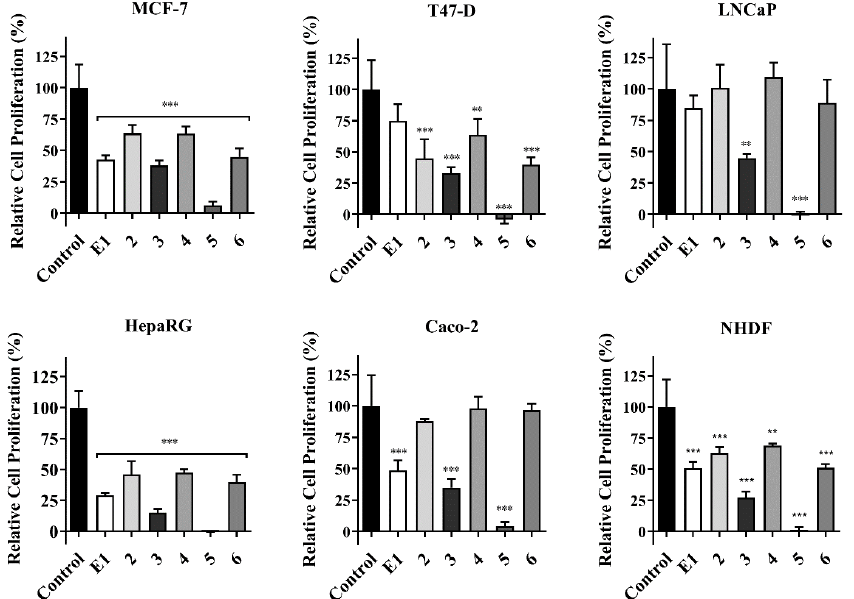
Figure 2. Relative cell proliferation of MCF-7, T47-D, LNCaP, HepaRG, and Caco-2 cancer cells and normal fibroblasts (NHDF) exposed to the tested compounds for 72 h at 30 µM (MTT assay). Data are expressed as a percentage of cell proliferation relative to the negative control, are presented as mean ± SD, and are representative of at least two independent experiments. ** p < 0.01; *** p < 0.001 vs. control (Student t -test).